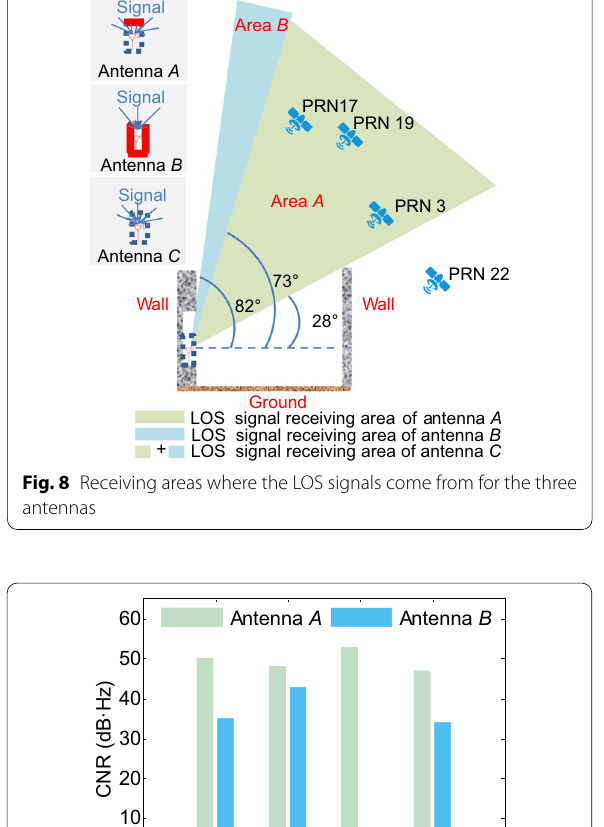
Table 2 Information on the satellites observed by antenna A and B